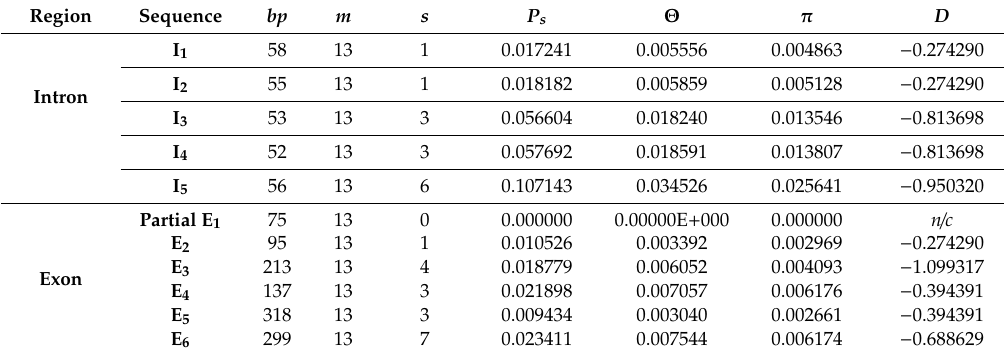
Table 2. Genetic polymorphism and neutrality tests of EF1 α partial gene sequences of 12 Polish isolates and partial genome sequence (gi:752829739) of P. gigantea , including introns and exons. Region